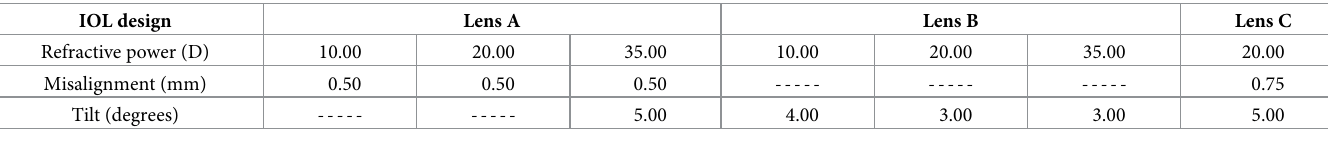
Table 3. Minimum values of misalignment and tilt for which MTF is below 0.43 (for 100 cycles per degree and a 3.00 mm diameter